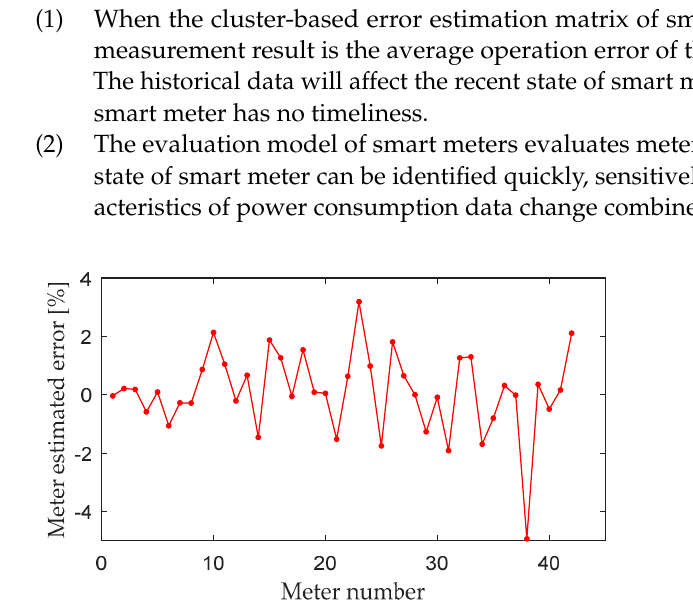
Figure 10. Results of cluster-based operation error method of electric energy meters. Table 5. Results of evaluation